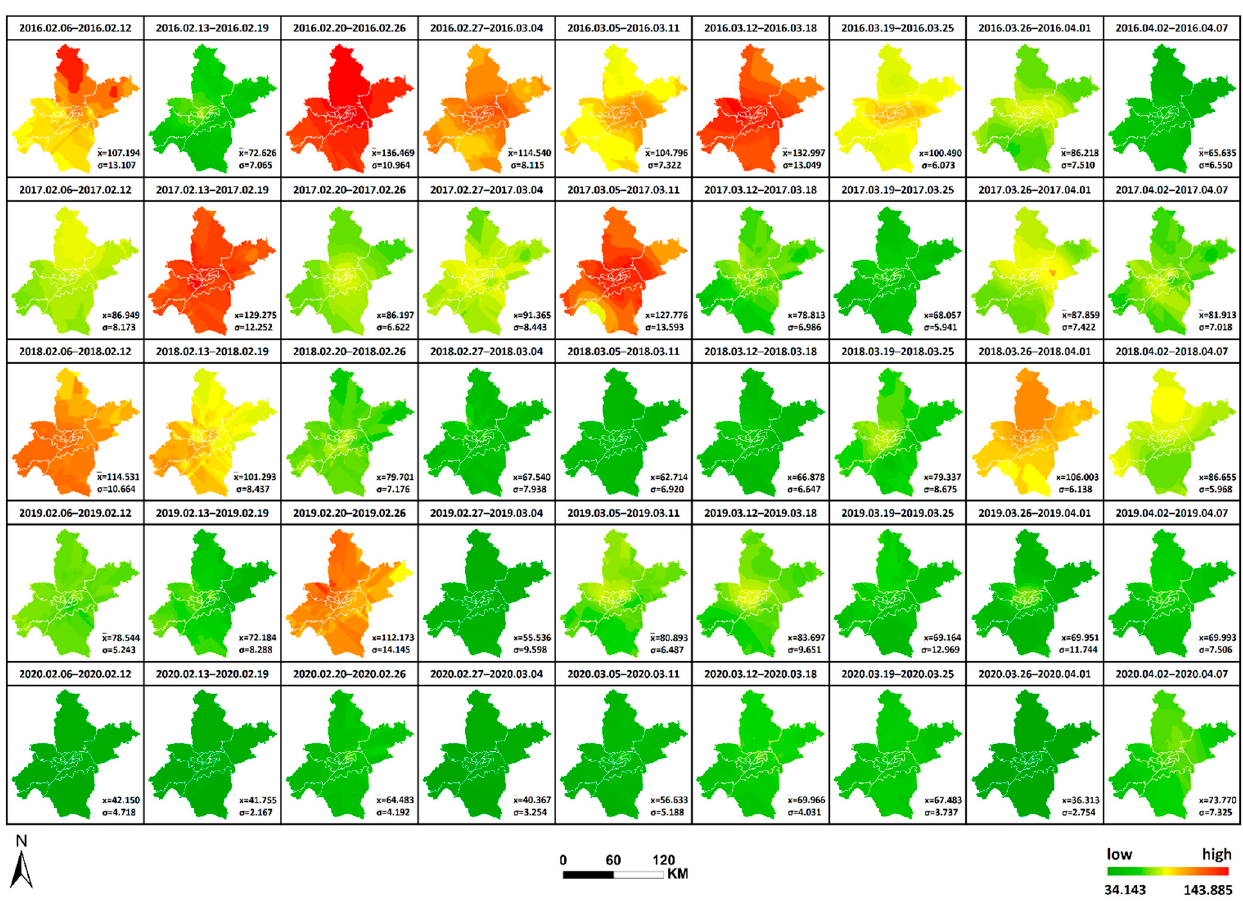
Figure 6. AQI interpolation chart from 2016 to 2020. Table 3. AQI maximum/minimum statistics from 2016 to 2020.